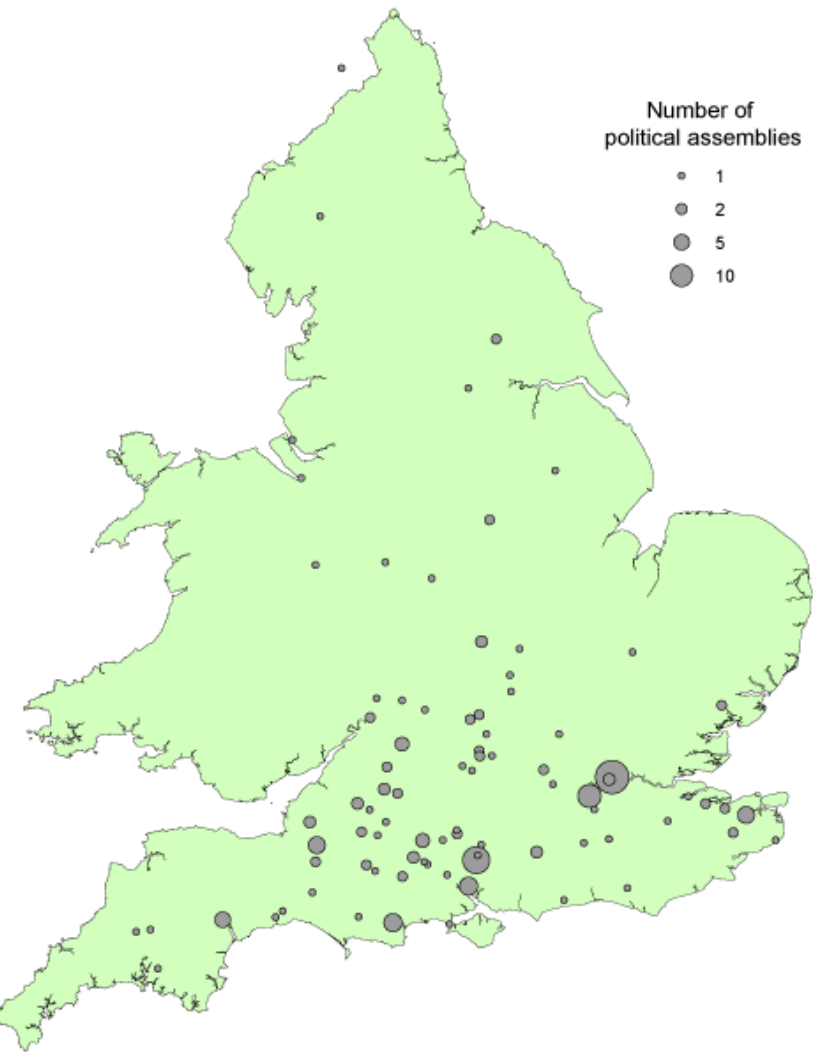
Fig. 4: The frequency of political assemblies – the witangemot – as recorded in later Anglo- Saxon written